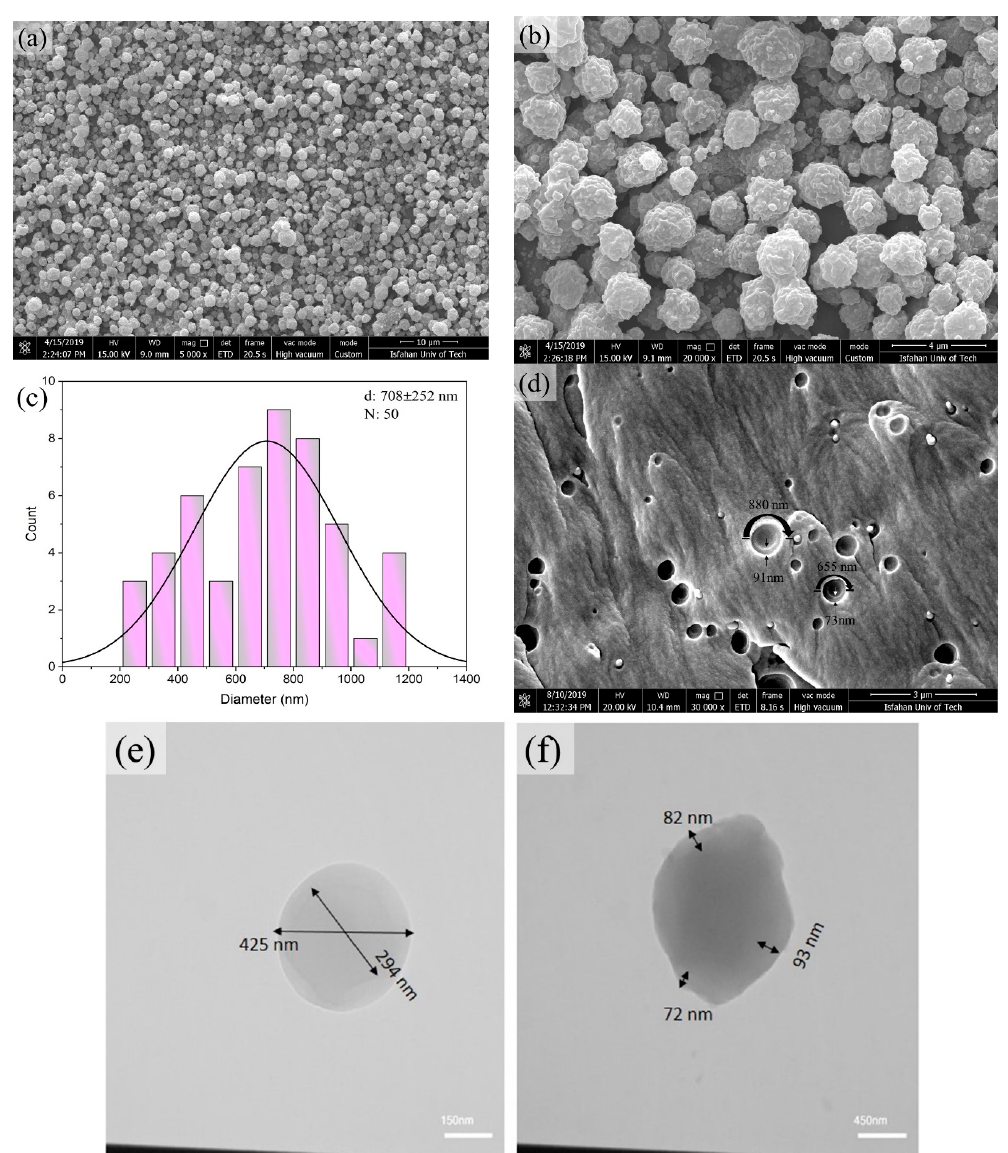
Figure 4. FE-SEM micrographs of the prepared nanocapsules at: ( a ) 5000× and ( b ) 20,000× magnification; ( c ) the size distribution of nanocapsules; ( d ) FE-SEM image of the fractured capsules in the epoxy composites; and ( e , f ) TEM images of the prepared nanocapsules.